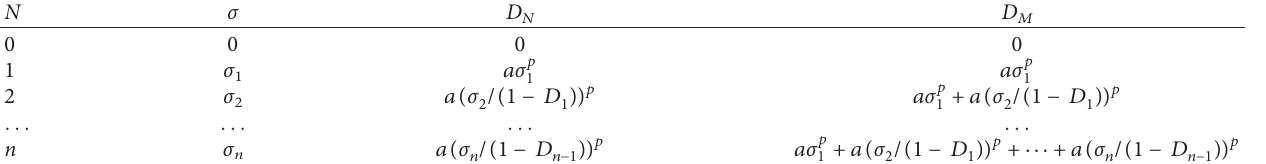
Table 1: Simplified Chaboche nonlinear fatigue damage model damage evolution and accumulation law.